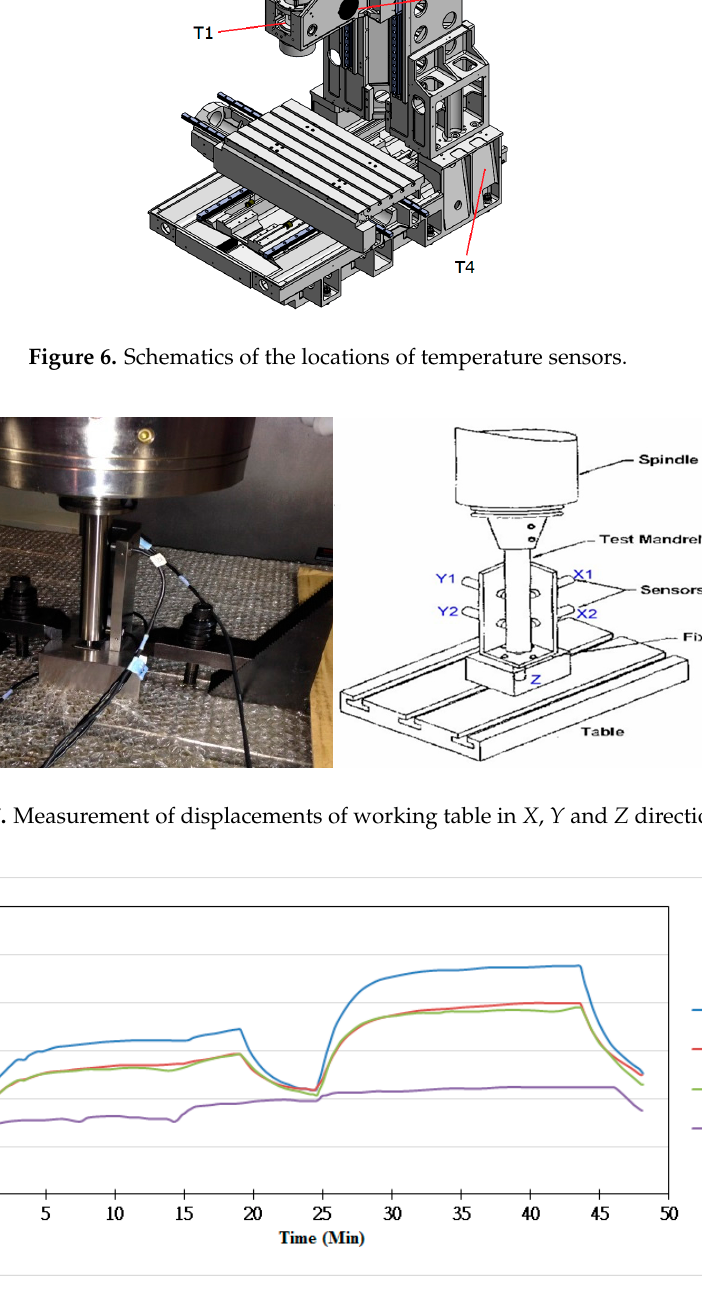
Figure 8. Temperature rises with time measured at four sensors.